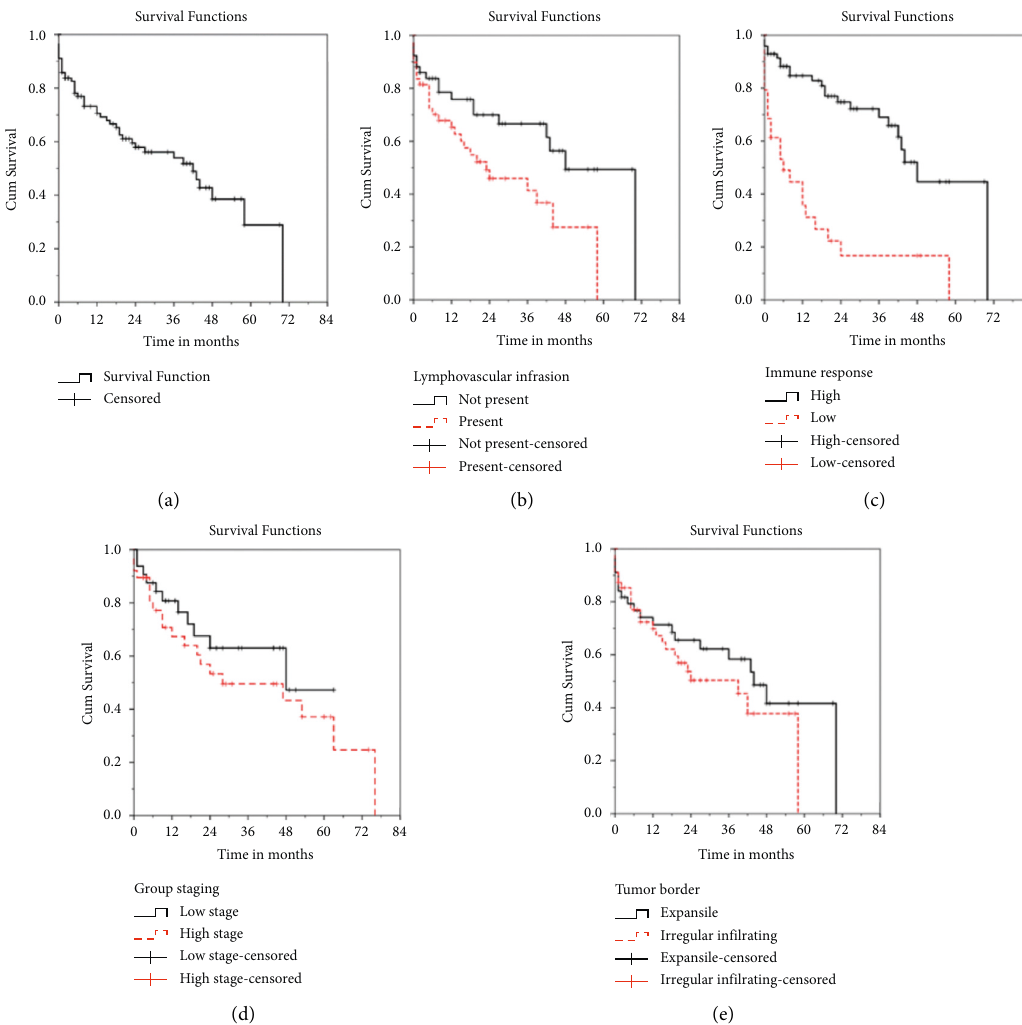
Figure 4: Kaplan–Meier survival curves: (a) Kaplan–Meier overall survival curve, (b) Kaplan–Meier survival according to lympho-vascular invasion: log-rank test and P value � 0.018 , (c) Kaplan–Meier survival according to the immune response status: log-rank test and P value � 0.001 , (d) Kaplan–Meier survival according to the stage groups: log-rank test and P value � 0.227 , and (e) Kaplan–Meier survival according to the tumor border: log-rank test and P value � 0.321